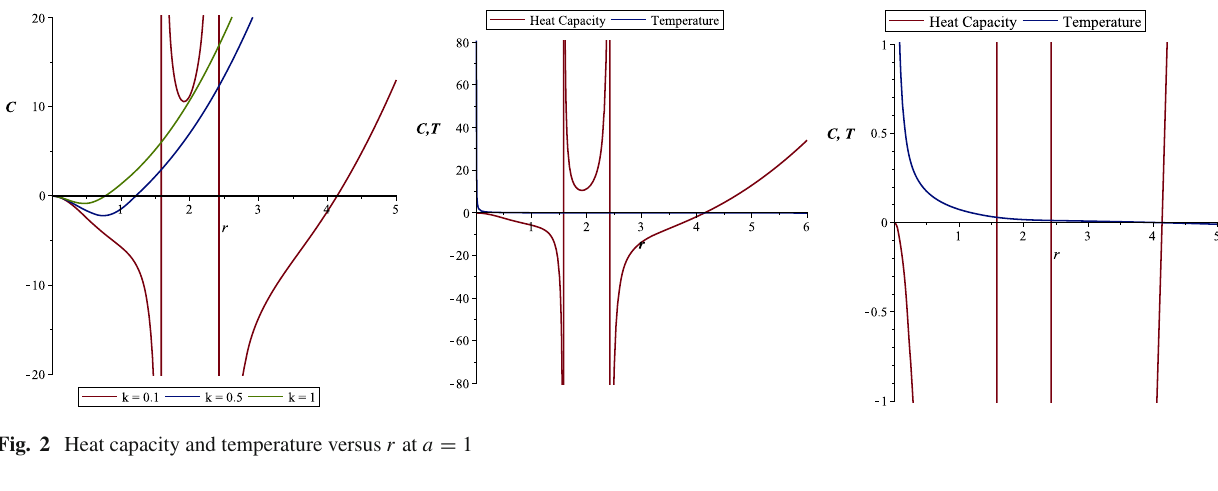
Fig. 3 r + , BP versus k for Eq. (18)